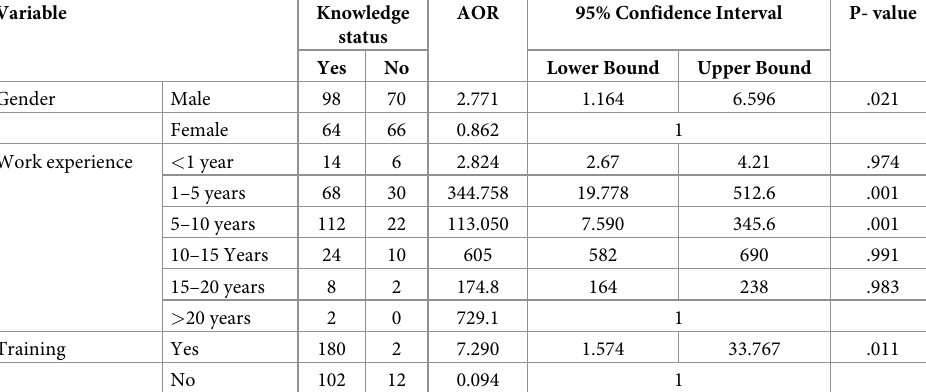
Table 5. Multivariate logistic regression analysis of factors related to knowledge regarding biomedical waste